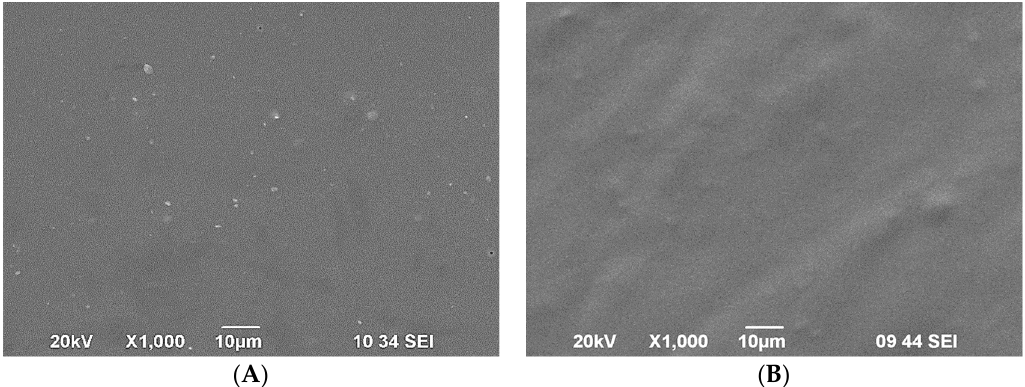
Figure 3. SEM micrographs of ( A ) hybrid zinc and ( B ) ordinary zinc coatings.